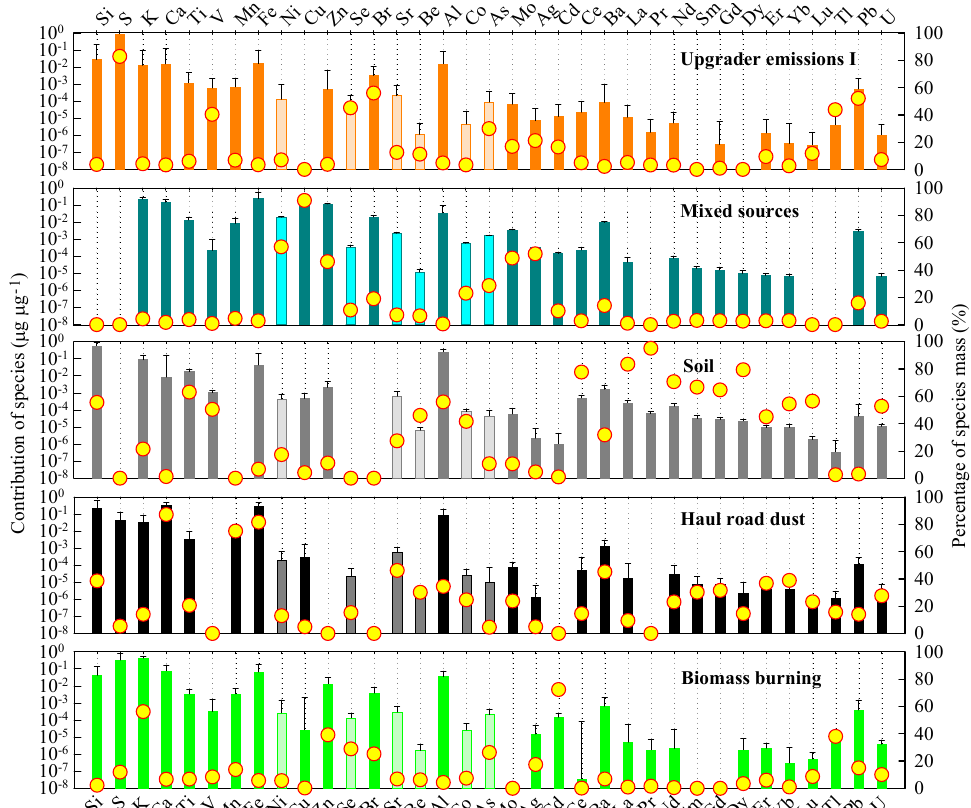
Figure 3. Factor profiles of the combined filter data. Filters were collected once every 6 days at three sites for 2 years (December 2010– November 2012) and daily at one site in August 2013. Factor concentrations depicted as bars; percentages depicted as circles. Error bars represent standard deviations estimated by 100 bootstrap runs. Elements with Shannon entropy below 3.5 have been given a higher trans- parency than the remaining